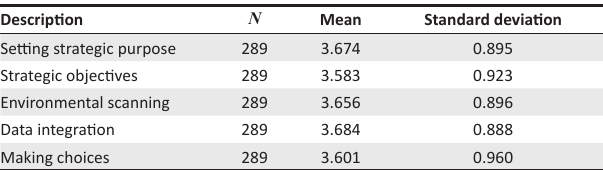
FIGURE 1: Summary of strategy formulation amongst small and medium TABLE 3: Overall means of five activities.